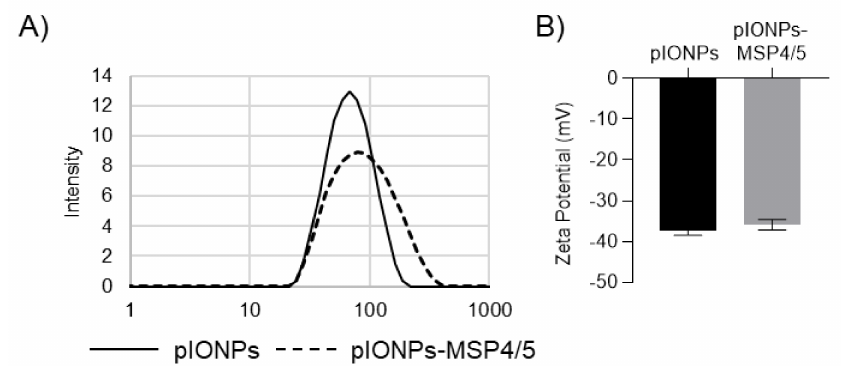
Figure 5. Conjugation of pIONPs to MSP4 / 5. pIONPs were conjugated to MSP4 / 5 using EDC chemistry. This led to particles with a final concentration of 83.8 ± 4.2 µ g MSP4 / 5 protein / mg pIONPs. ( A ) Hydrodynamic size of pIONPs before and after conjugation to MSP4 / 5. ( B ) Zeta potential of the pIONPs before and after conjugation. In total, 1–3 independent measurements were taken, with SD determined over all replicates.